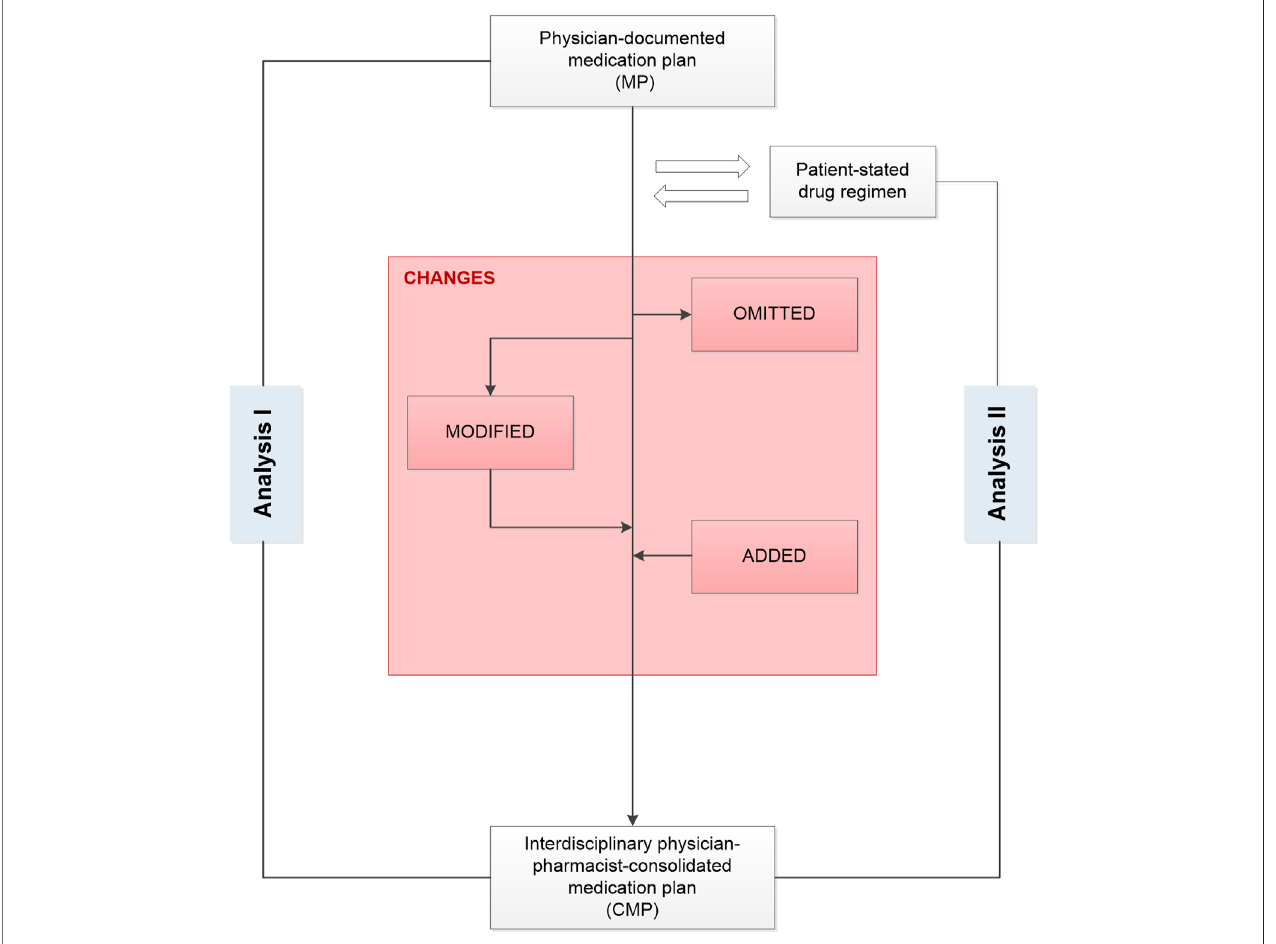
FIGURE2| Developmentofaninterdisciplinaryconsolidatedmedicationplanaftercomparingthedruginformationinthemedicationplandocumentedbythestudy physician with the results of the interview between the pharmacist and the patient in a medication review. CMP, consolidated medication plan; MP, medication plan.